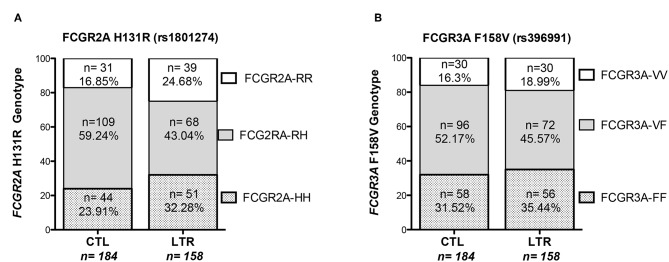
Distribution of FCGR3A and FCGR2A genotypes in LTRs and CTLs. The proportion of the FCGR2A (left Panel, A) and FCGR3A (right panel, B) genotypes resulting from the SNP allelic combination were analyzed in a cohort of 158 LTRs and 184 CTLs recruited in southern France.